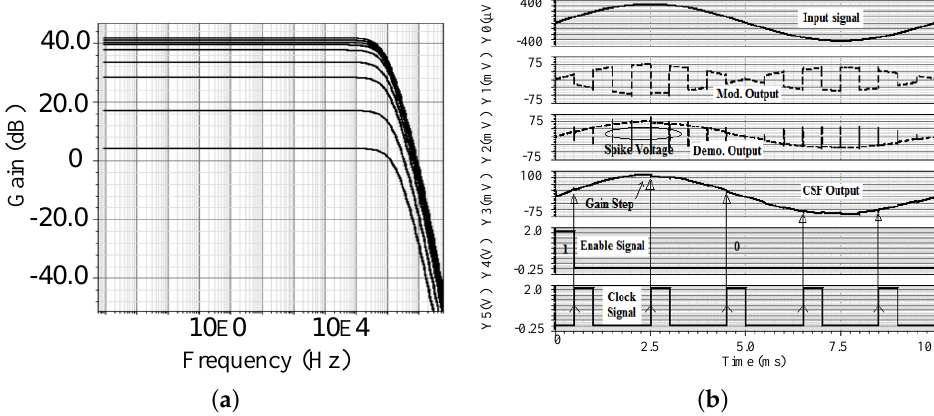
Figure 10. CLPGA simulation results: ( a ) bode transfer function for different gains; and ( b ) control of the f Clk = 0.5 kHz and input sine wave of 360 µ V and 100 Hz.